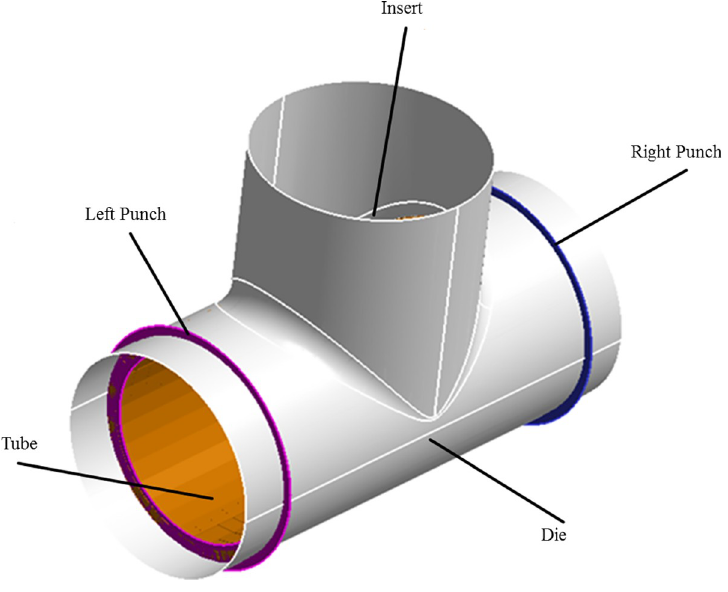
Fig 10. Finite element model.